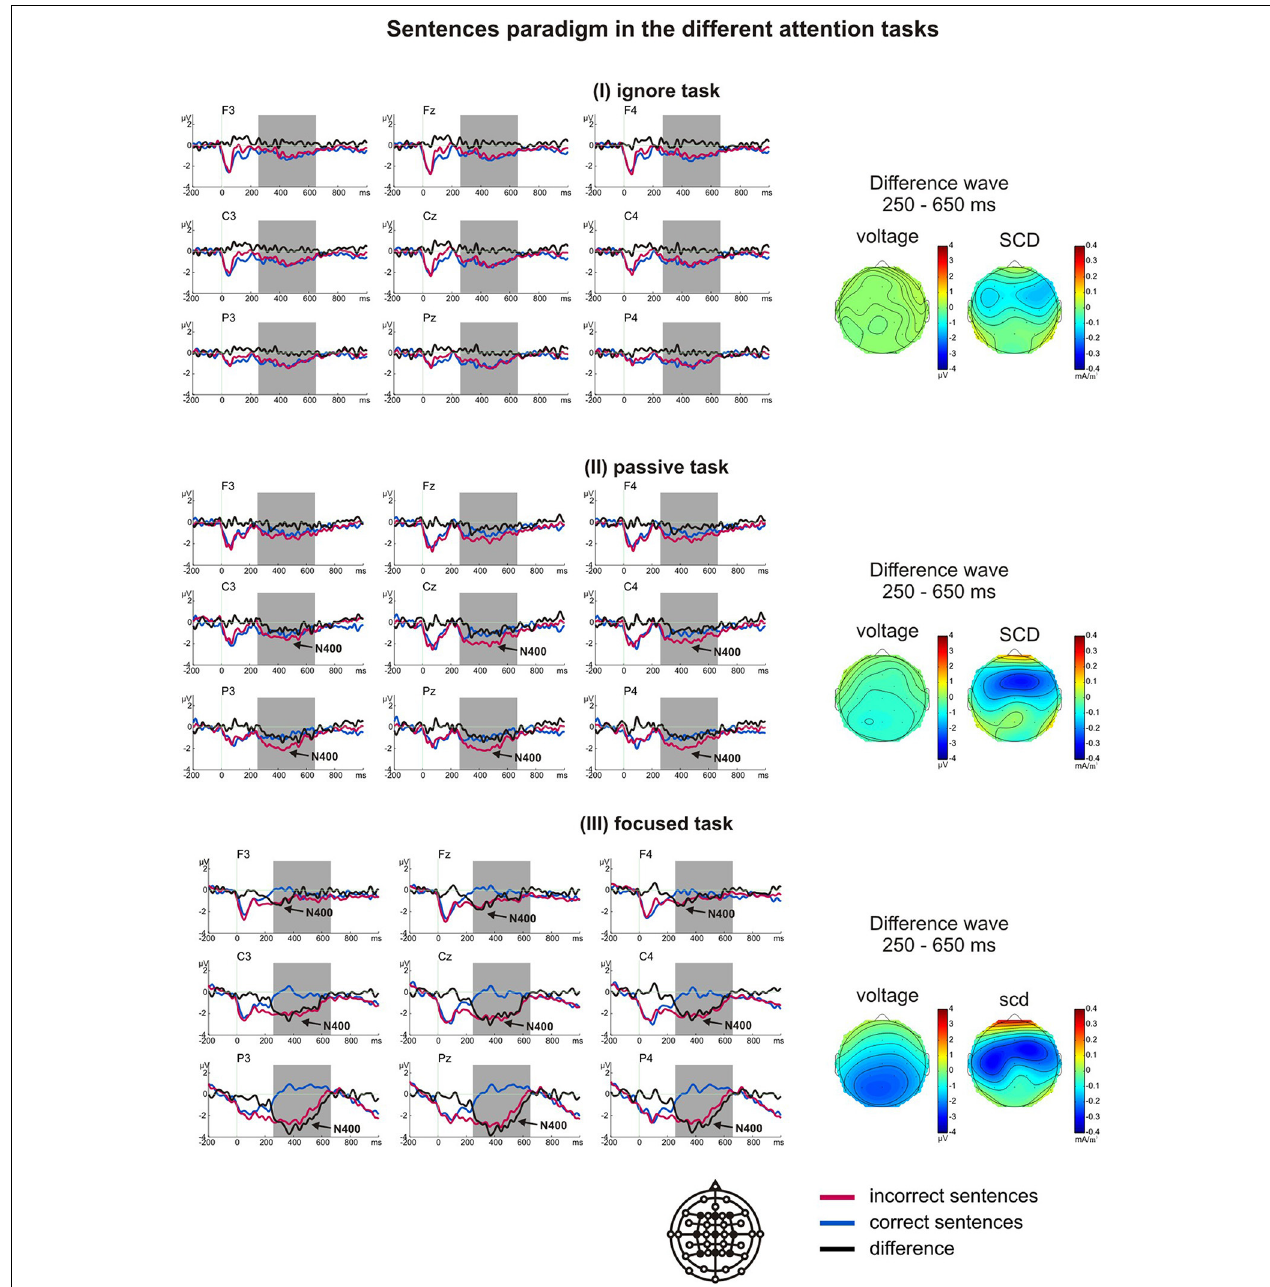
FIGURE 4 | Grand average ERPs of the sentence paradigm in the ignore task (I), passive task (II) and focused task (III). The arrows indicate whether the N400 difference was significantly different from zero within the analyzed